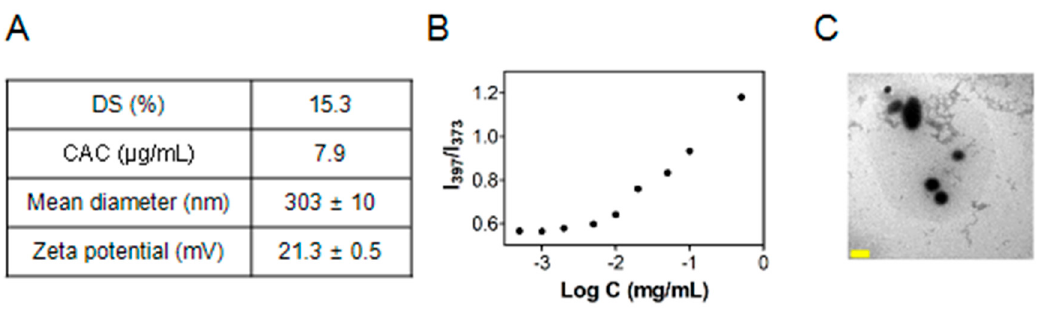
Figure 2. Synthesis and identification of CHS-CS. ( A ) Synthetic sketch of CHS-CS. ( B ) Proton nuclear magnetic resonance ( 1 H-NMR) spectra of chitosan (CS) (I) and CHS-CS (II).